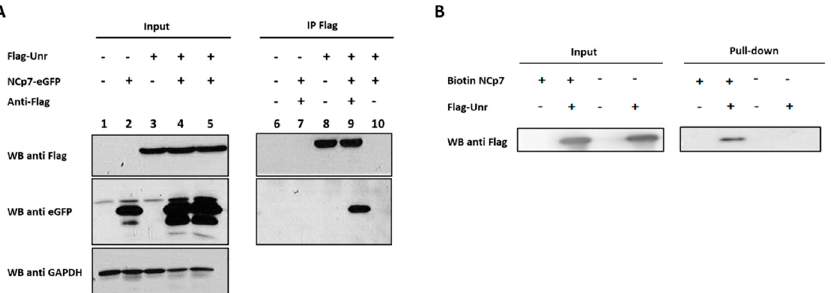
13 of 21 Figure 7. Unr/GagG2A interaction monitored by FRET-FLIM. HeLa cells were transfected with DNA constructs encoding eGFP-Unr in the absence ( A1 ) and the presence of GagG2A-mCherry ( A2 ). Live cells were imaged 24 h post-transfection. The eGFP fluorescence lifetimes were deter- mined using a single-exponential model and converted into a color code ranging from blue (1.6 ns) to red (2.4 ns). ( B ) Fluorescence lifetimes of eGFP-Unr, in the presence of GagG2A-mCherry, were analyzed by one or two populations analysis. The lifetimes are expressed as mean ± SEM for about 20 cells. For the two populations analysis, the long lifetime was fixed to 2.41 ns, and the shorter lifetime as well as its amplitude were determined and expressed as mean ± SEM for about 20 cells. The bar scale represents 10 μ m. 3.7. NCp7 and Gag Interaction with Unr Monitored by Co-Immunoprecipitation To confirm the interaction between Unr and Gag/NCp7, we performed co-immuno- precipitations (co-IP) on 293T cells co-transfected with constructs encoding Flag-Unr and NCp7-eGFP. The immunoprecipitates were analyzed by Western blot. All the fusion pro- teins were well overexpressed, as observed in the input lanes 1–5 in Figure 8A. As Flag- Unr is specifically immunoprecipitated by the anti-Flag antibody (in Figure 8A, compare lanes 8 and 9 with lane 10), the co-IP of NCp7-eGFP with Flag-Unr (compare lane 9 with lane 8) confirms that Flag-Unr and NCp7-eGFP interact specifically. The interaction be- tween NCp7 and Unr was further confirmed by the co-IP of eGFP-Unr with Flag-NCp7 using an anti-eGFP antibody (data not shown). Moreover, we also performed a pull-down with a synthetic NCp7 biotinylated at its N-terminus (Biotin-NCp7) and fixed on strep- tavidin beads before the addition of 293T cell lysates overexpressing Flag-Unr protein (Figure 8B). A Western blot using an anti-Flag antibody confirmed the expression of Flag- Unr (Figure 8B lanes 2 and 4) and the specific presence of Unr in the pull-downed fraction with beads covered by Biotin-NCp7. Finally, no co-IP could be observed when a lysate of cells co-expressing Flag-Unr and NCp7-eGFP was treated with RNase just before perform-